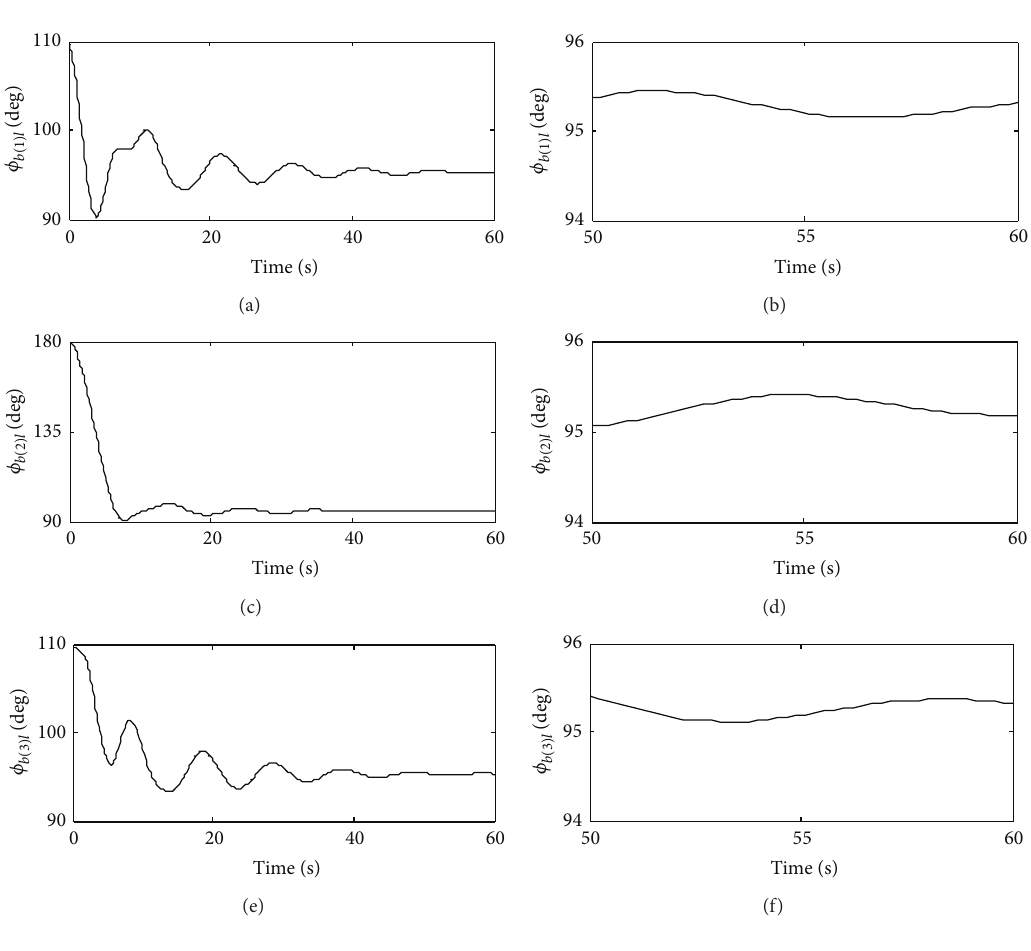
Figure 10: Information-state exchange topology.